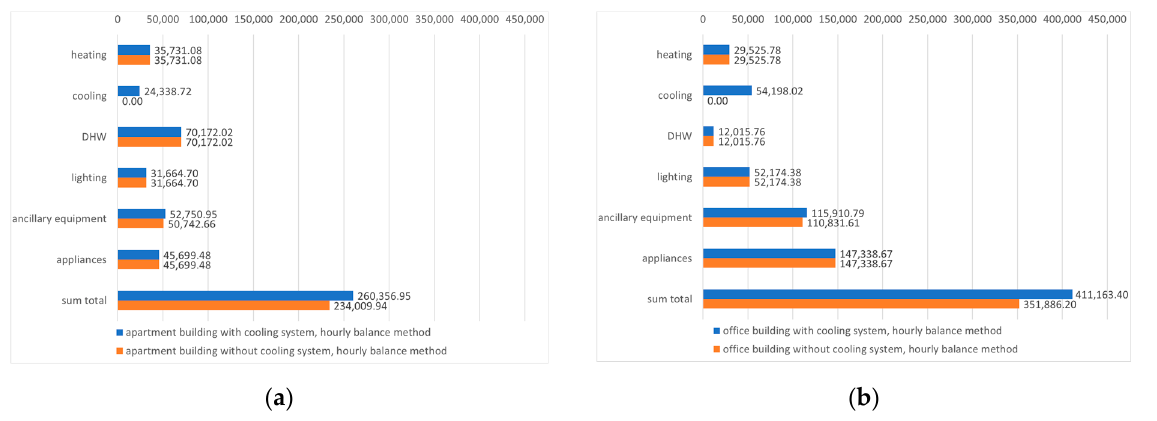
Figure 14. Primary energy demand for apartment building ( a ) and office building ( b ), equipped with cooling and without cooling.